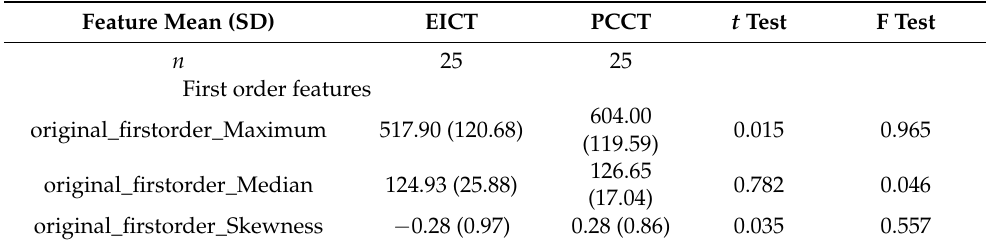
Table 2. Comparison of first-order radiomics parameters, extracted from myocardial segmentation. Variables mit significant differences in groups shown, for full table refer to supplemental material.